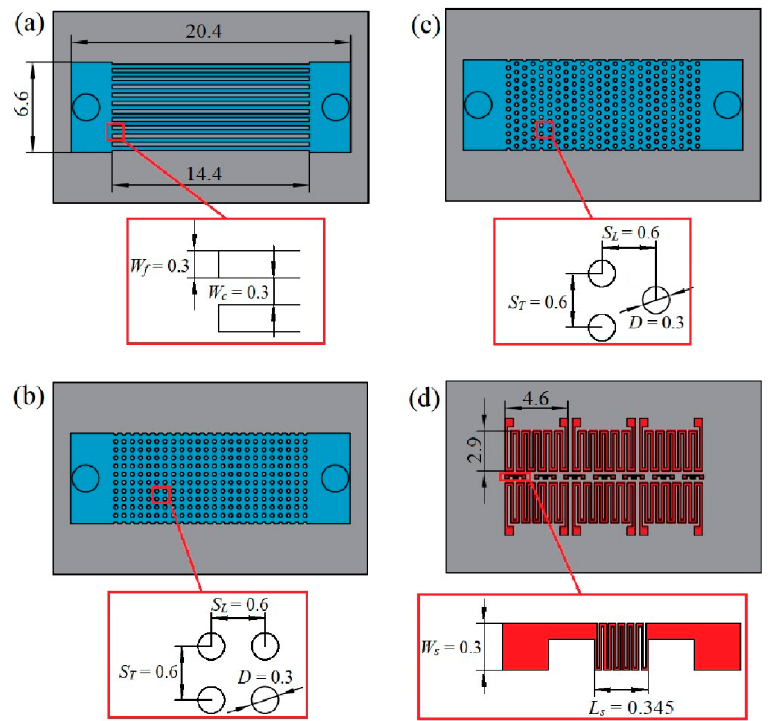
Figure 2. Structural illustration of the test chips: ( a ) the microchannel heat sink; ( b ) the inline micro-pin-fin heat sink; ( c ) the staggered micro-pin-fin heat sink; ( d ) the thin-film Ti / Pt heaters and sensors. (units: mm).